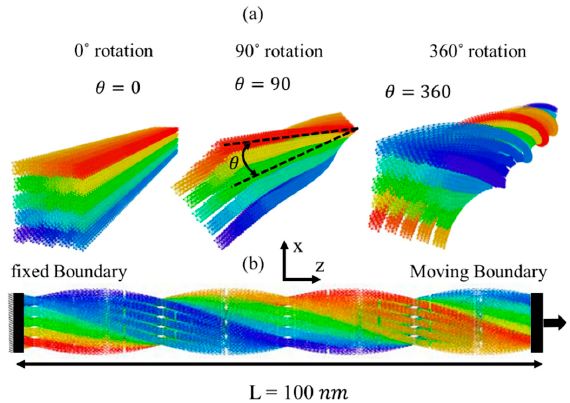
Figure 2. 5 × 5 bundles of CNC with different twisted angle ( θ ). ( a ) θ = 0°, 90°, and 360°; ( b ) side view of a 360° rotated bundle. Tensile displacement is applied on the boundary particles of one side while the boundary particles on the other side are fixed.